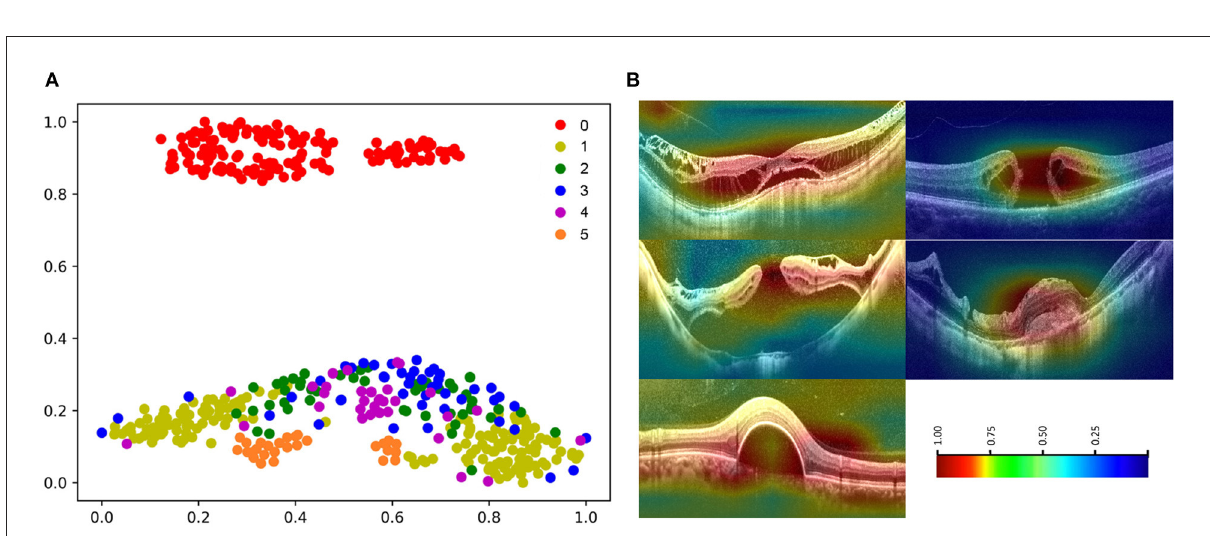
FIGURE8 Visualization of algorithm B. (A) The t-SNE plot of algorithm 0: normal macular, 1: macular schisis, 2: full-thickness macular hole, 3: MH with Retinal detachment, 4: mCNV, 5: others (PED). (B) Heatmap generated from deep features overlaid on the original images. The typical lesions were observed in the hot